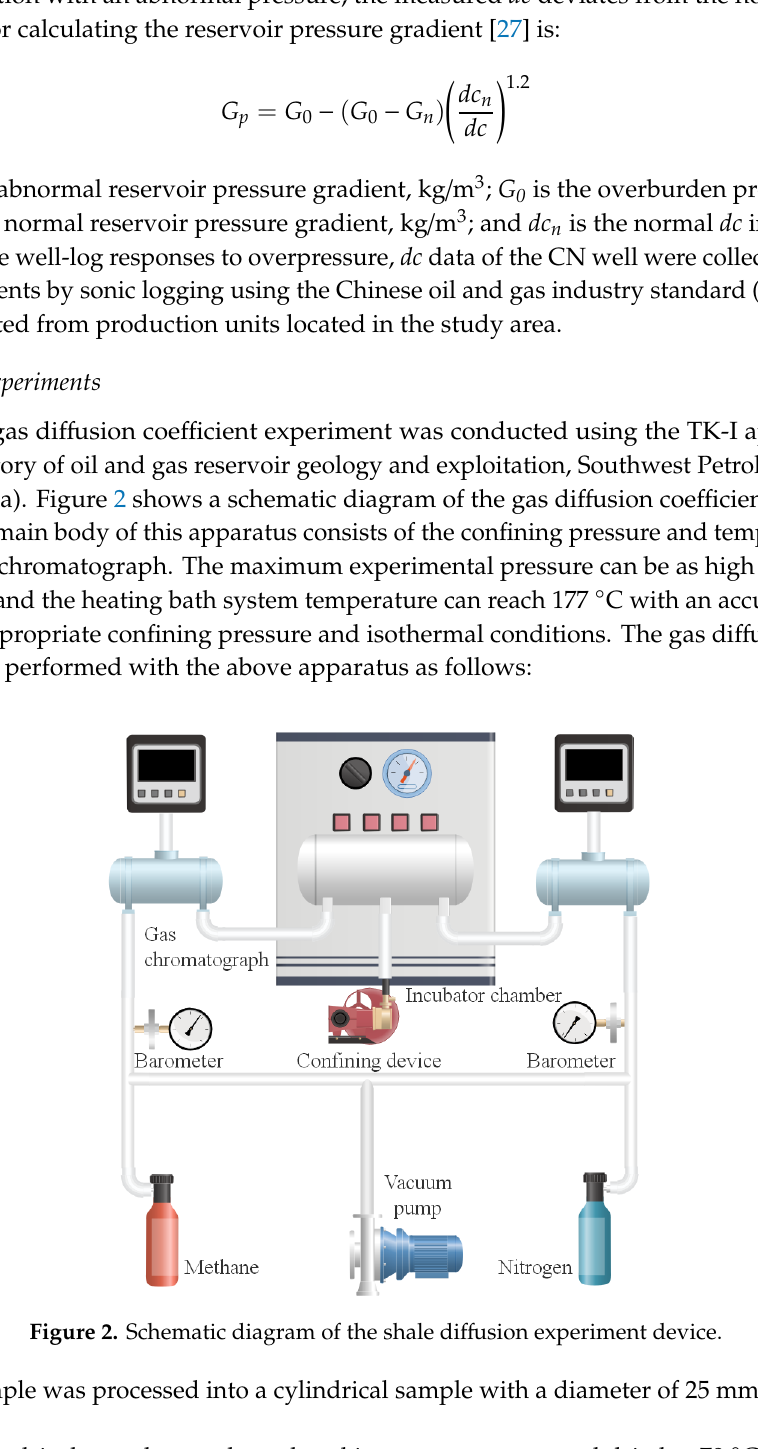
Figure 2. Schematic diagram of the shale diffusion experiment device.